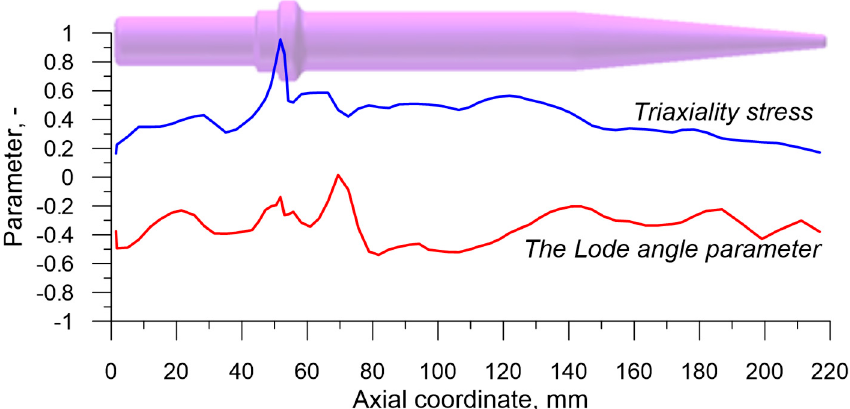
Figure 19. Characteristics of the stress state in the axis of the rolled part expressed by the averaged values of stress triaxiality and the Lode angle parameter.